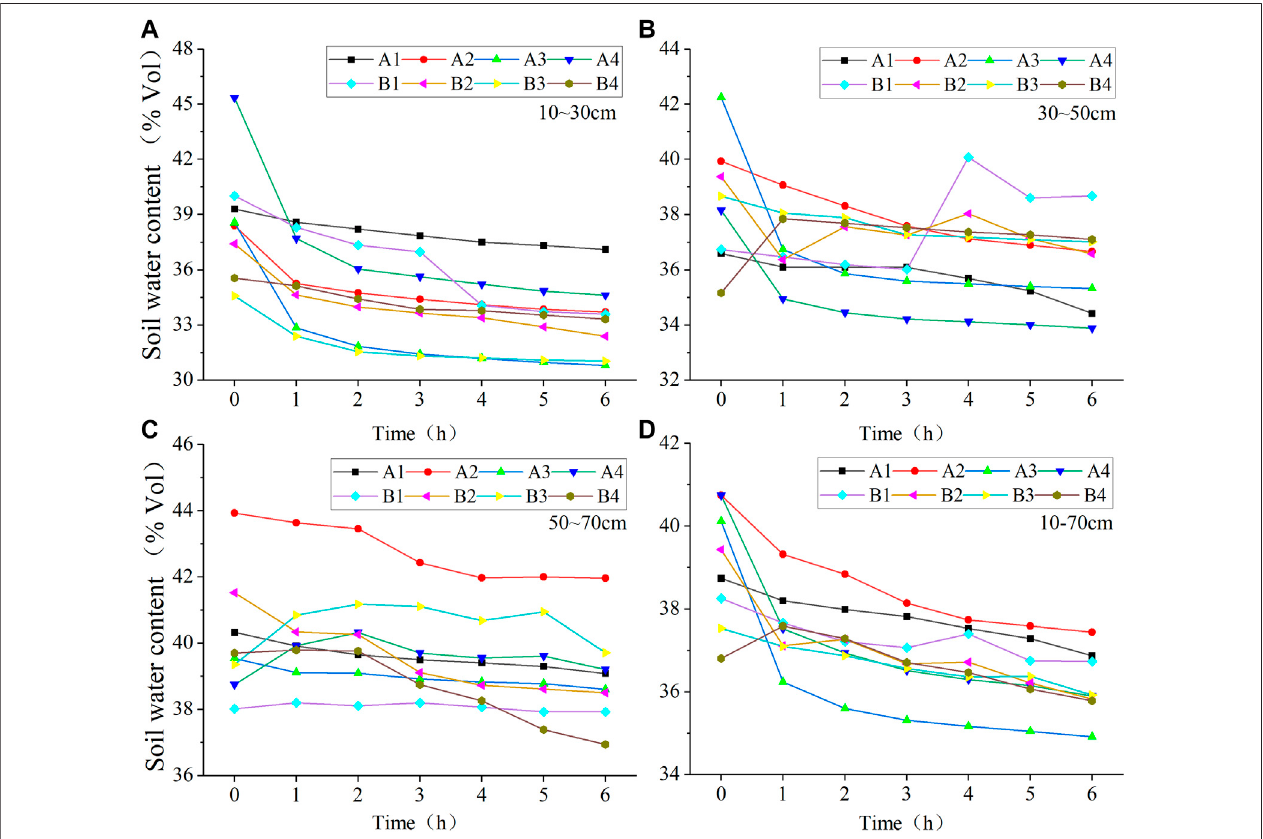
FIGURE 12 | Redistributions of soil water content in experimental plots at 10 – 70 cm depth from 1 to 6 h after rainfall ended (The letters (A-D) in the top left corner represent the different depths of soil).